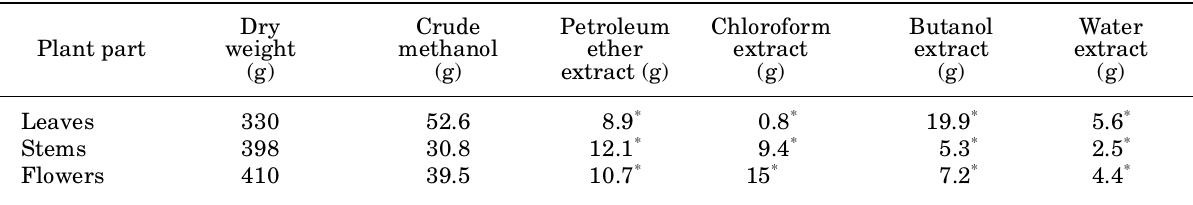
Table 2. Plant parts, dry weight and weights of the extracts of Euphorbia macroclada used in this study.